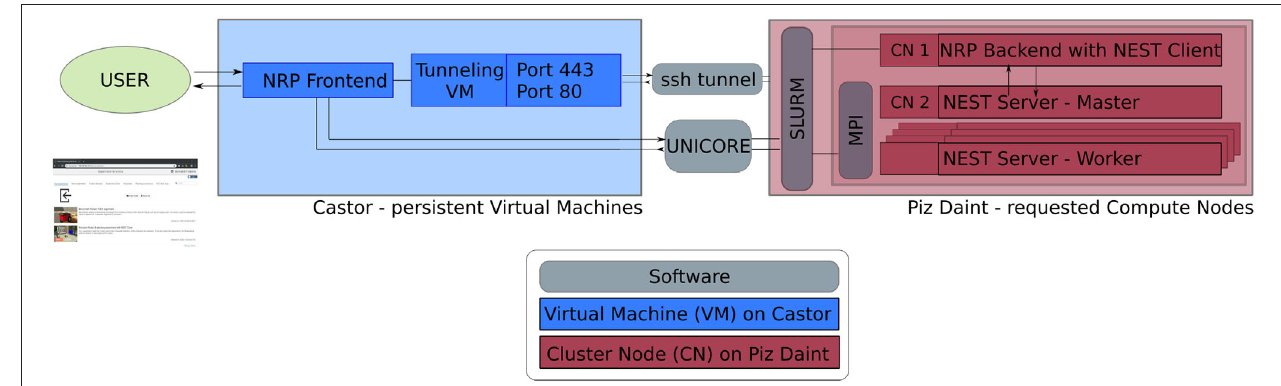
FIGURE 1 | Software architecture. Persistent virtual machines are interfaced with requested compute resources in order to offer a flexible user interface with HPC resources. We use UNICORE as an interface to schedule compute jobs, and a SSH tunnel on demand establishes the bidirectional connection between NRP frontend and backend running on the two distinct computing systems.